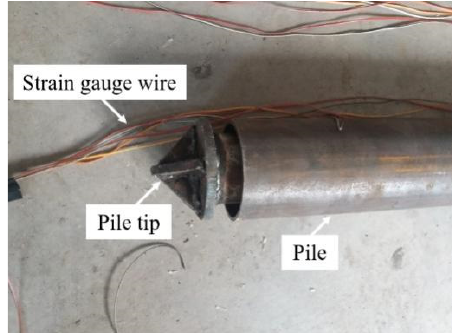
Figure 2. Schematic diagram of the pile-end soilless compressive